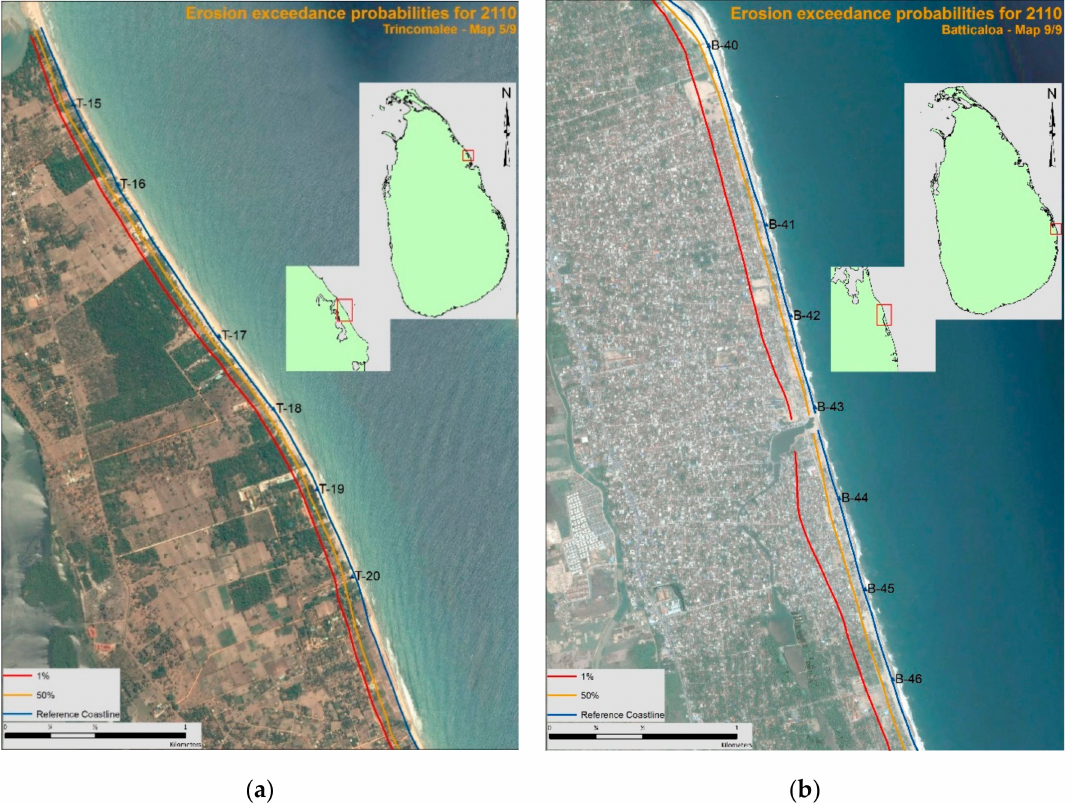
Figure 18. Examples of computed 1% (red) and 50% (orange) exceedance probability coastal recession contours in Trincomalee ( a ) and Batticaloa ( b